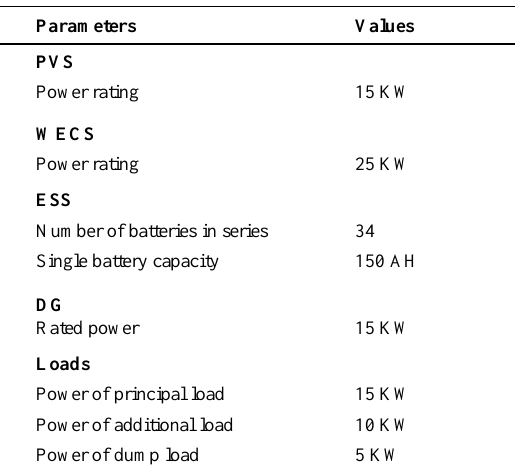
Table 1. Parameters of